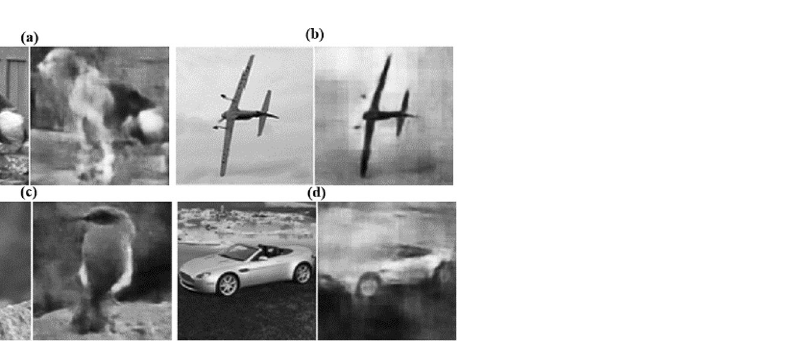
Figure 10. Validation set image reconstruction. ( a ) SSIM = 0.5214, PSNR = 17.62 dB, ( b ) SSIM = 0.6518, PSNR = 18.77 dB, ( c ) SSIM = 0.6913, PSNR = 18.79 dB, ( d ) SSIM = 0.4645, PSNR = 15.12 dB.